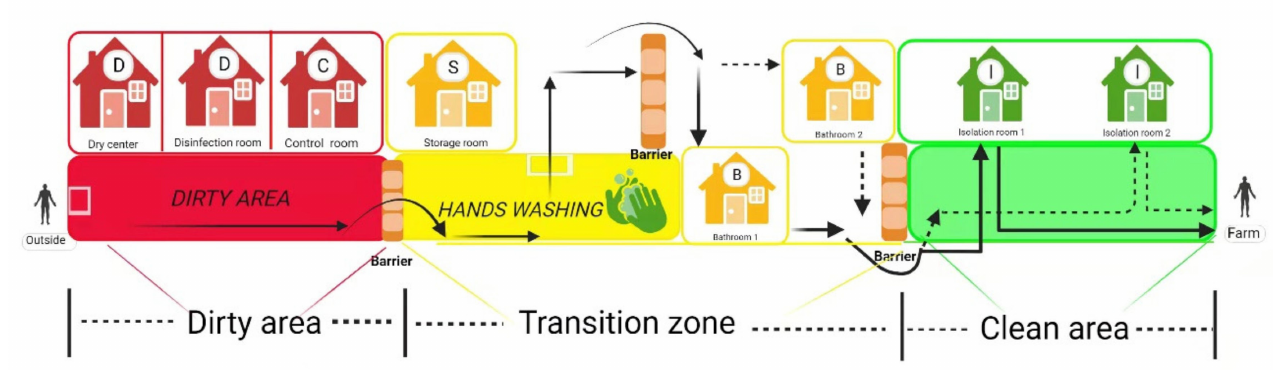
Figure 3. The structural diagram of staff entrance corridor and isolation rooms. Arrows stand for the one-way walking route. Employees leave their “dirty” clothes, shoes, and hats in the dirty area, wash their hands and take a bath in the transition zone, and then put on clean overalls and boots to move into the isolation rooms where they stay for 2 days. Dry center (60 ◦ C, >20 min) and disinfection room (materials that cannot withstand high temperatures, such as special medicines or vaccine products, ozone fumigation, or ultraviolet irradiation [101] can be used to disinfect the materials) are used for goods disinfection. The control room and storage room are used for monitoring the entrance of staff and the storage of disinfected goods, respectively. (Copyright agreement number is EF23BRLLLP).